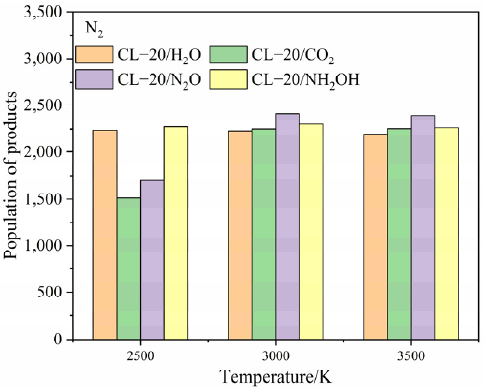
Figure 12. The population of N 2 after the complete decomposition reaction for CL-20/H 2 O, CL-